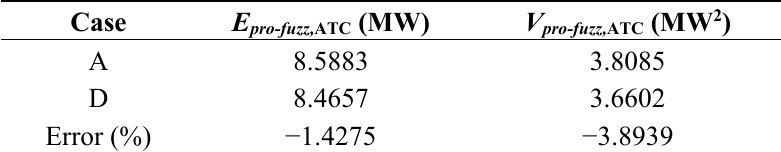
Table 2. The results of Case A and Case D.